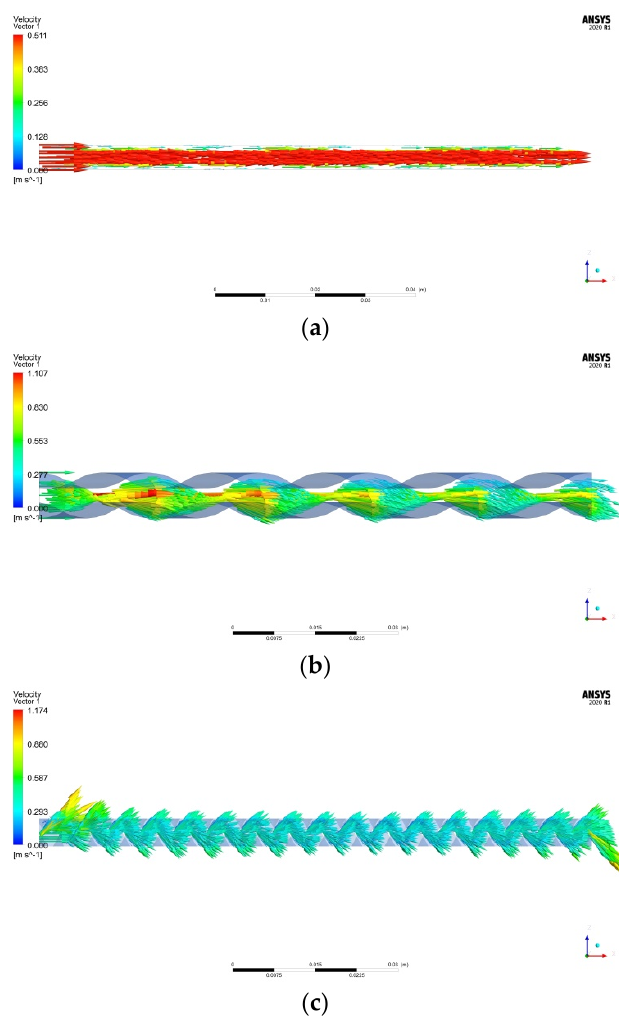
Figure 9. Fluid velocity vectors: ( a ) flat heat exchange plate; ( b ) chevron heat exchange plate; ( c ) plate with conical stamping.